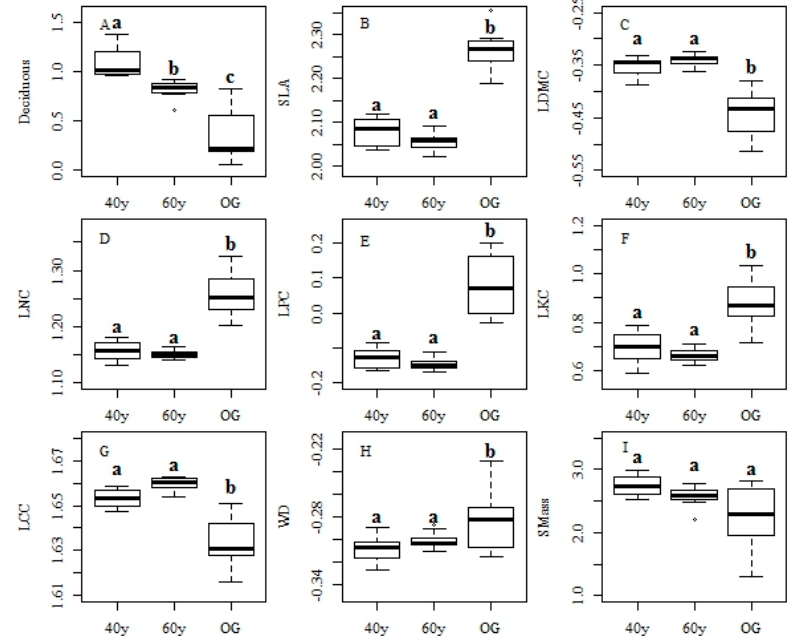
Figure 4. The changes in nine functional traits (mean ± SD) with the secondary succession of monsoon forests. Subfigures ( A – I ) respectively showed the changes of deciduousness (Deciduous), specific leaf area (SLA), leaf dry matter content (LDMC), leaf nitrogen content (LNC), leaf phosphorus content (LPC,), leaf potassium content (LKC), leaf carbon content (LCC), wood density (WD) and mass (S Mass , g). The nine functional traits using community-weighted means were computed based on tree basal area, and all traits were log-transformed. The successional stages were 40-year-old forests (40y), 60-year-old forests (60y), old-growth forests (OG). Different letters (a, b, c) demonstrated significant different at p < 0.05.